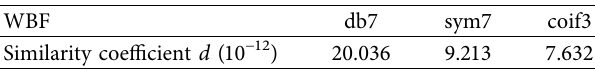
Table 3: The average value of the similarity coefficient d . WBF